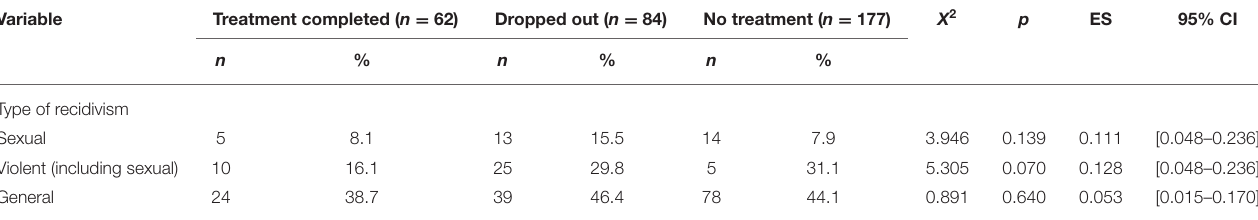
TABLE 2 | Sexual, violent, and general recidivism for the three groups (treatment completed, dropped out, no treatment).